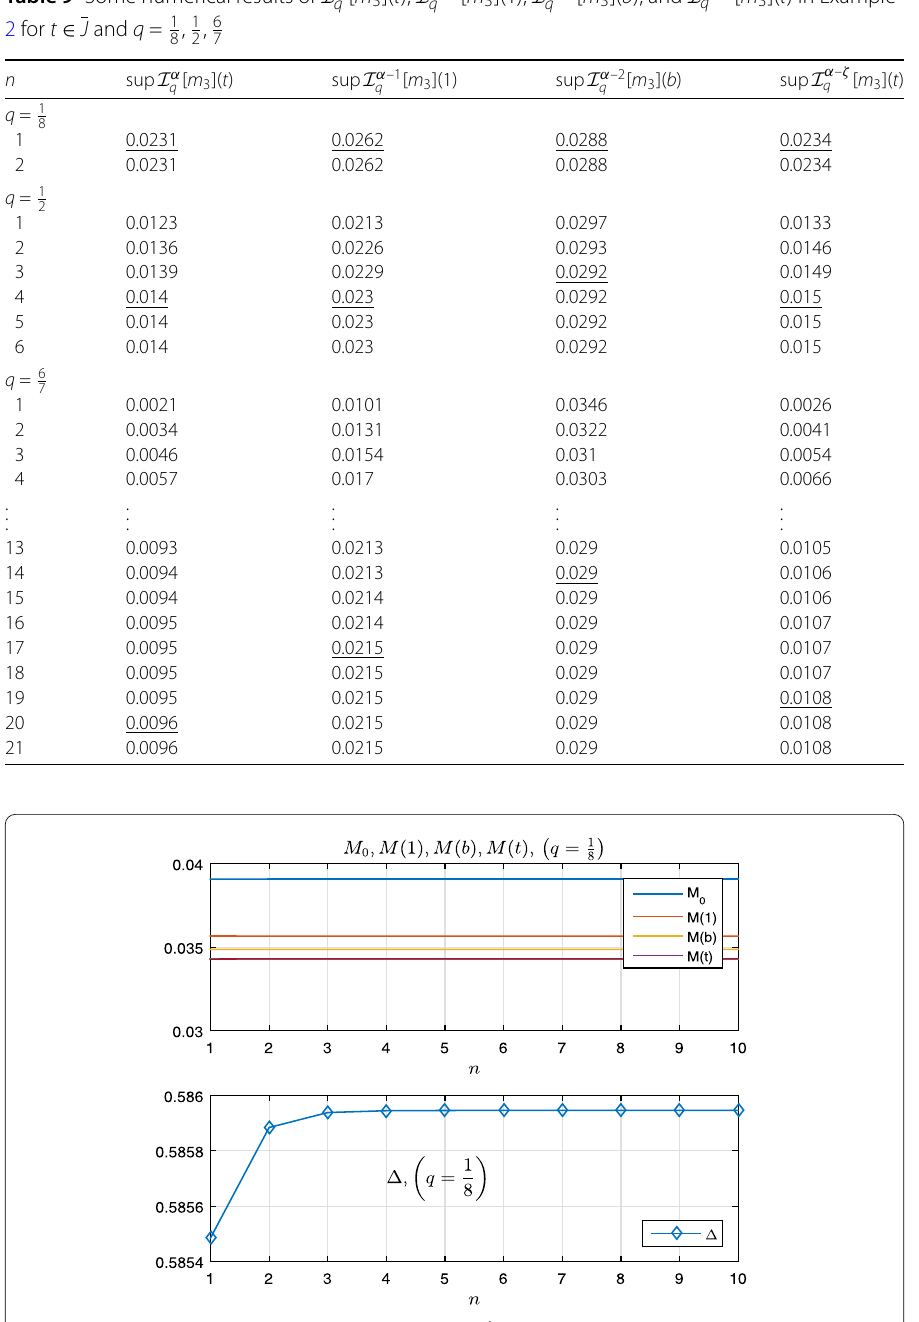
Figure 7 2D graphs of M 0 , M (1), M ( b ), M ( t ) on t ∈ J for q = 1